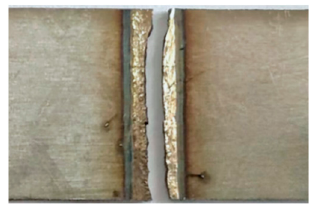
Figure 11. Joint fracture location.